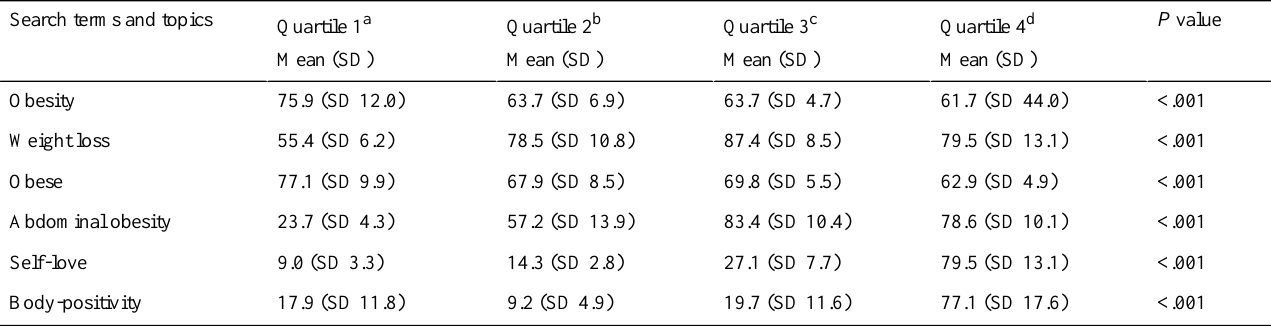
Table 1. Relative interest scores of search terms and